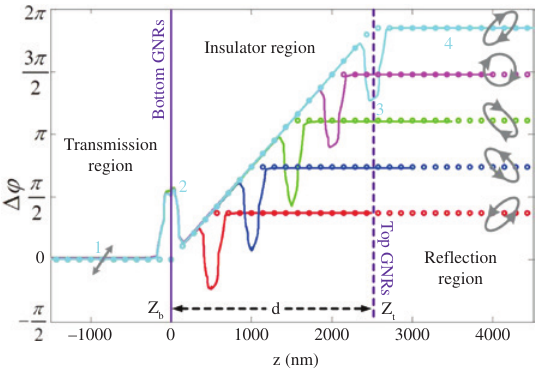
Figure 21: Dependence of the nonlinear phase difference Δ φ on z determined for different values of the thickness of the insulator layer: d = 0.5 μ m (red line), d = 1 μ m (blue line), d = 1.5 μ m (green line), d = 2 μ m (purple line), and d = 2.5 μ m (cyan line). The solid lines and circles indicate the numerical and analytical results, respectively. Reproduced from Ref.